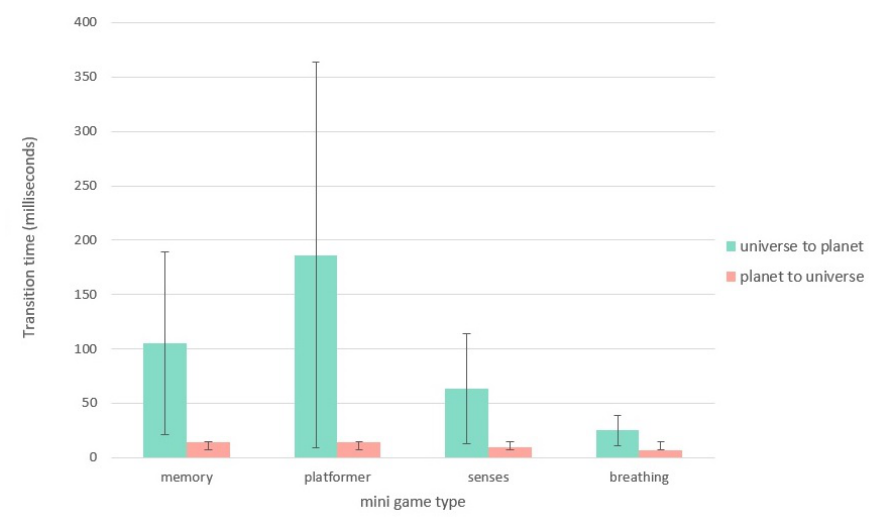
Figure 8. The average of five measures, in milliseconds, for the transition times between universe and planet for all mini-game types. The tests were performed on a Google Pixel XL device with Android 9.